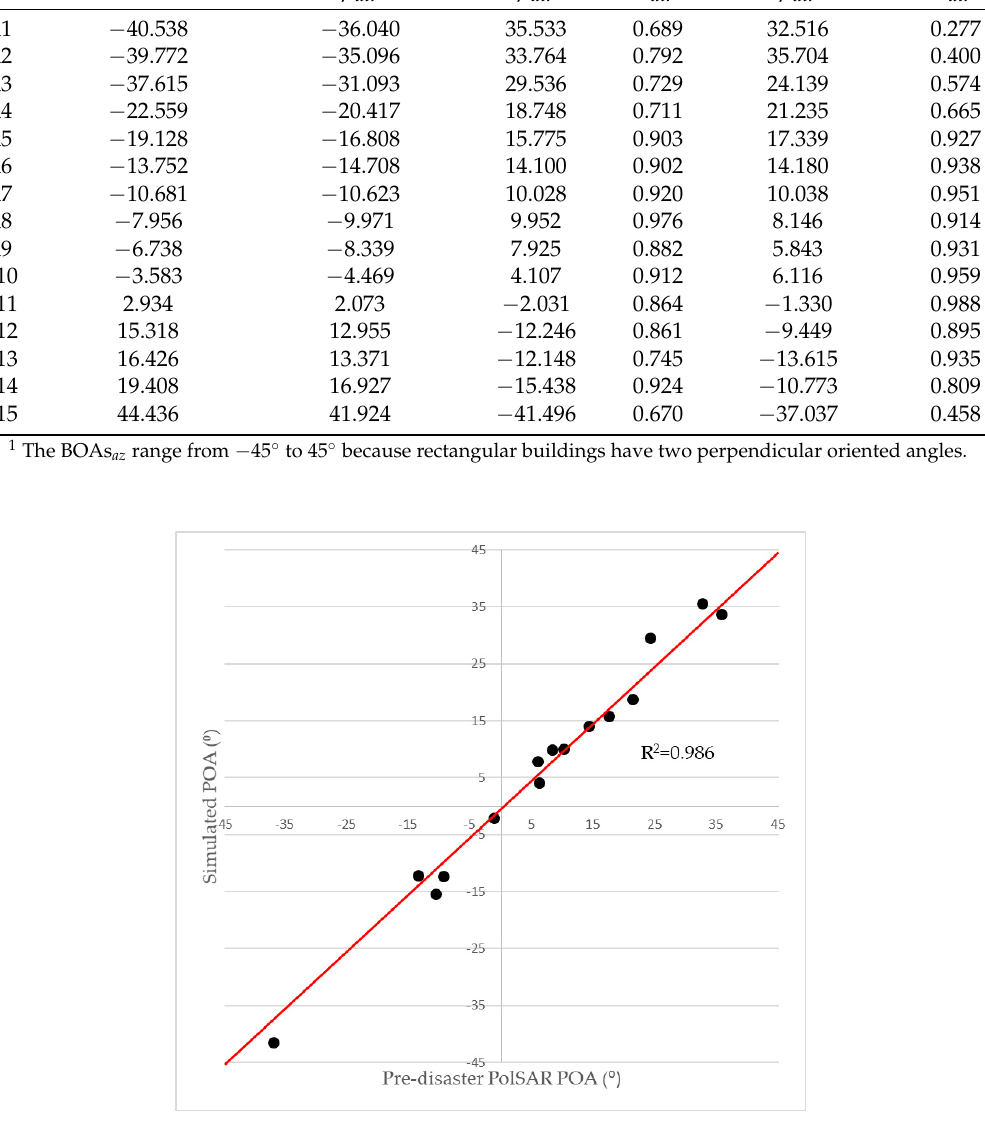
Figure 9. The directional means of the simulated POA versus the pre-tsunami PolSAR POA for the 15 selected regions. The red line indicates that the two POAs are corresponding.